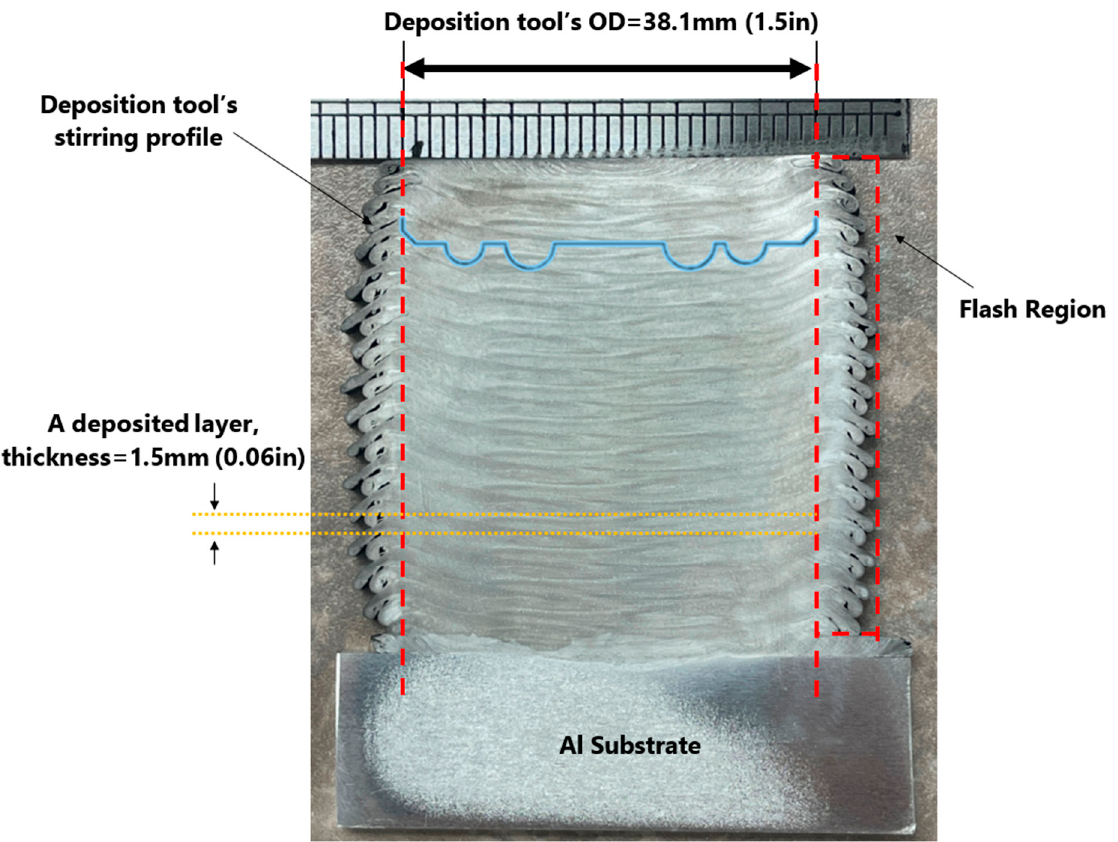
Figure 3. Polished and etched cross-section of the studied Al2050 as-deposited AFSD part showing the 3D layered structures.